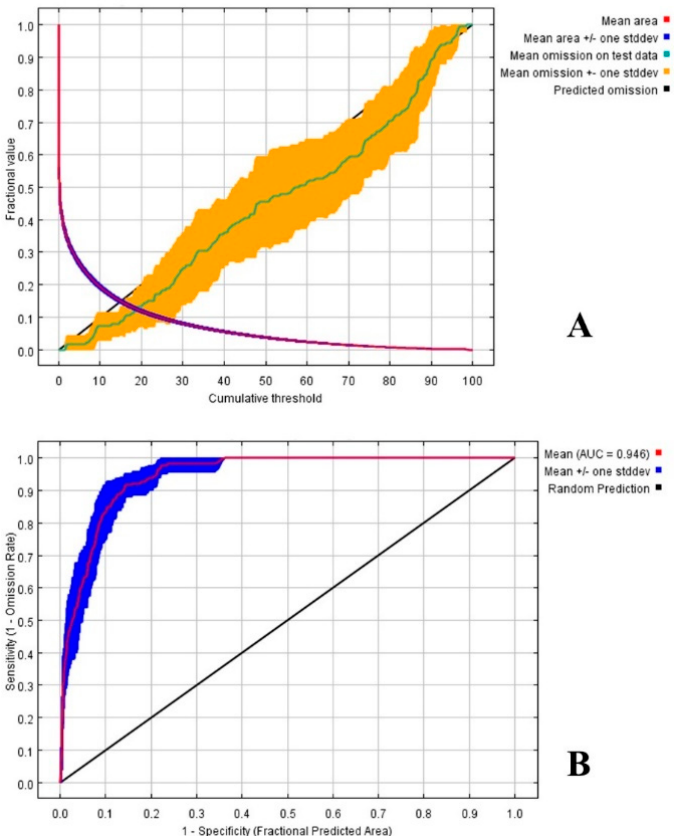
Figure 2. Model prediction accuracy analysis. ( A ) Average omission and predicted area for Sirex noctilio ; ( B ) Average sensitivity vs. 1-specificity for Sirex noctilio.